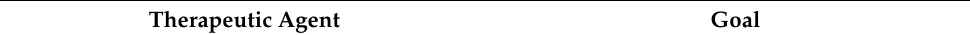
Table 2. Possible NK cell-based immunotherapeutic strategies to leverage NK cells to target